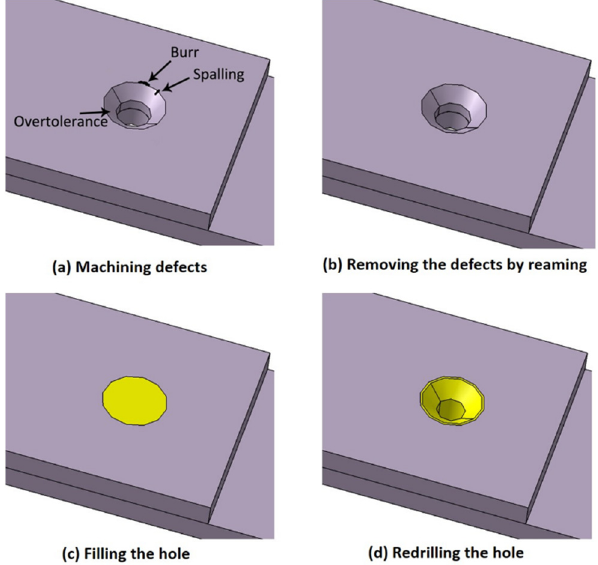
Figure 2. Illustration of the short fiber filling repair method for repairing defective composite joints.